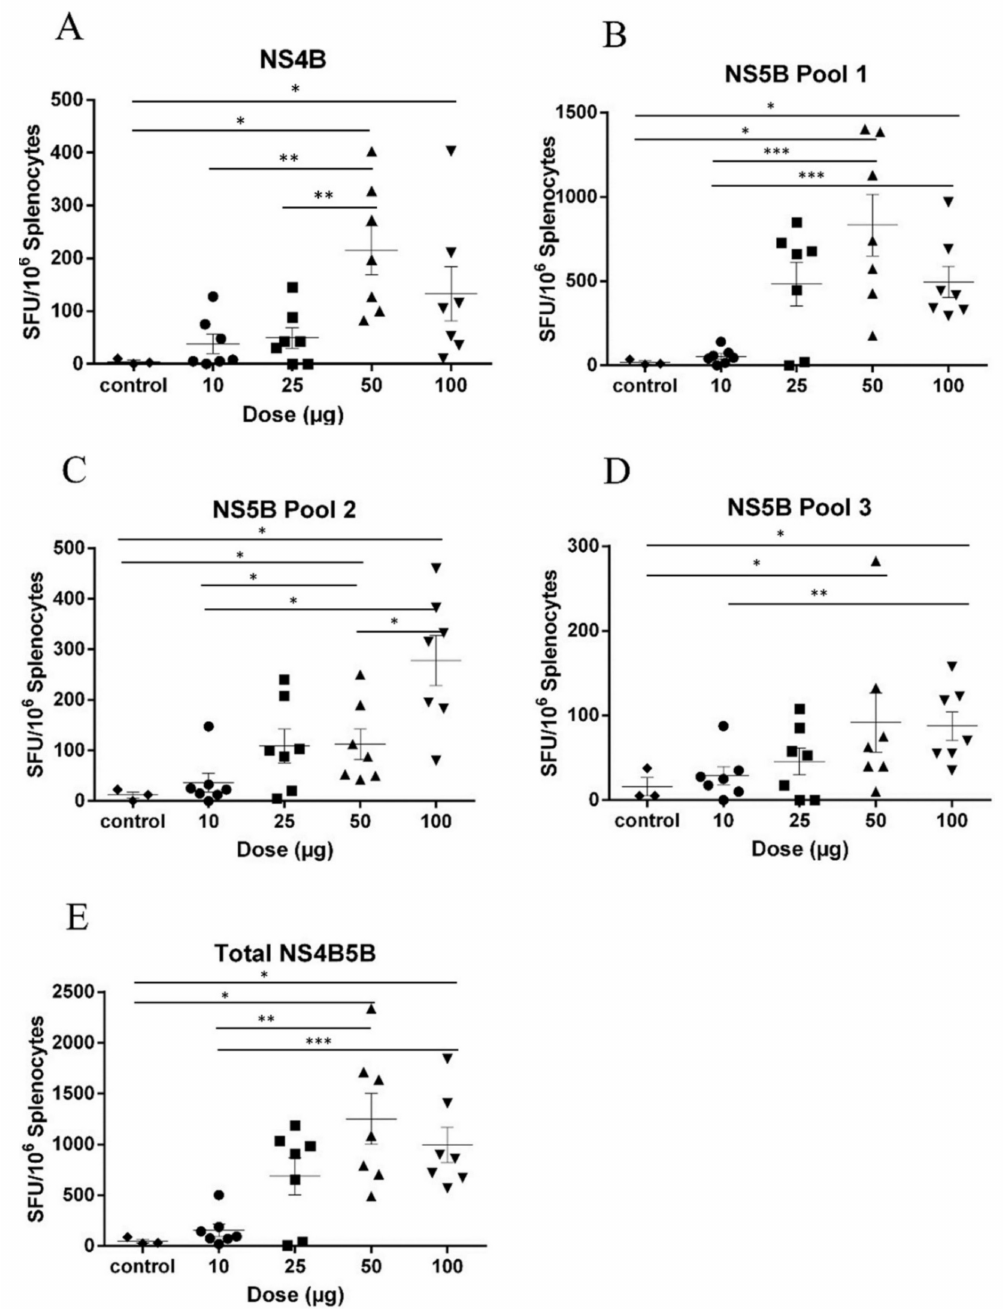
Figure 3. Titration of pNS4B / 5B in C57BL / 6. Mice were vaccinated three times at two week intervals with pNS4B / 5B and splenocytes were harvested 14 days post final vaccination. Splenocytes were re-stimulated with overlapping peptides representing the HCV ( A ) NS4B ( B ) NS5B Pool 1 ( C ) NS5B Pool 2 ( D ) NS5B Pool 3. ( E ) NS4B and NS5B combined analysis. Each symbol represents an individual mouse and data are shown as mean ± SEM of SFU per 10 6 splenocytes. Significance shown between control and dose groups. No significant di ff erences were observed between dose groups. * p ≤ 0.05; ** p ≤ 0.01; *** p ≤ 0.001 (Mann–Whitney test non-parametric t